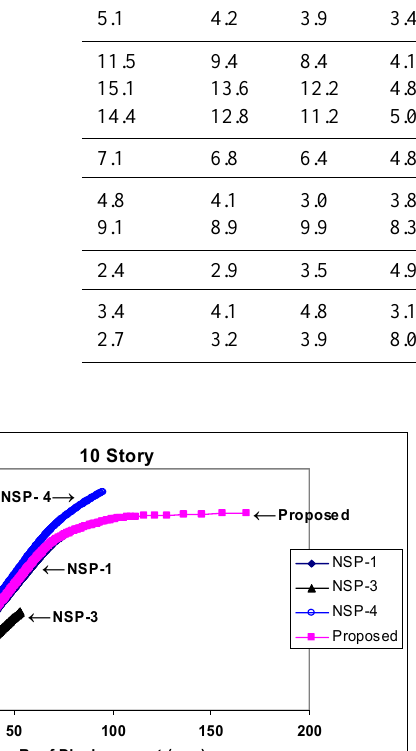
Figure 14. Base shear vs. roof drift response using different lateral load profiles for 3-storey building